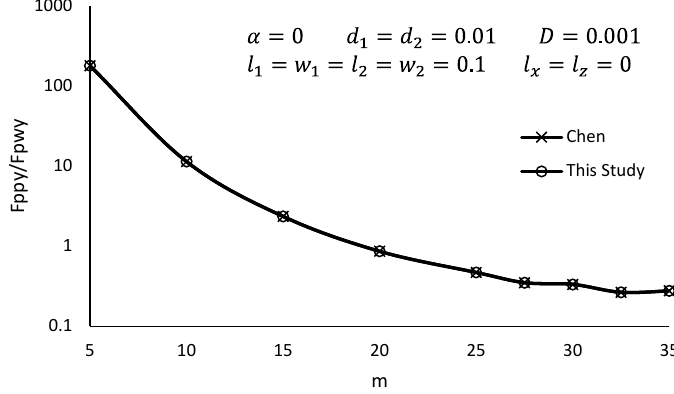
Figure 4. Comparison of numerical solutions based on Chen’s plate-plate model and the present model.